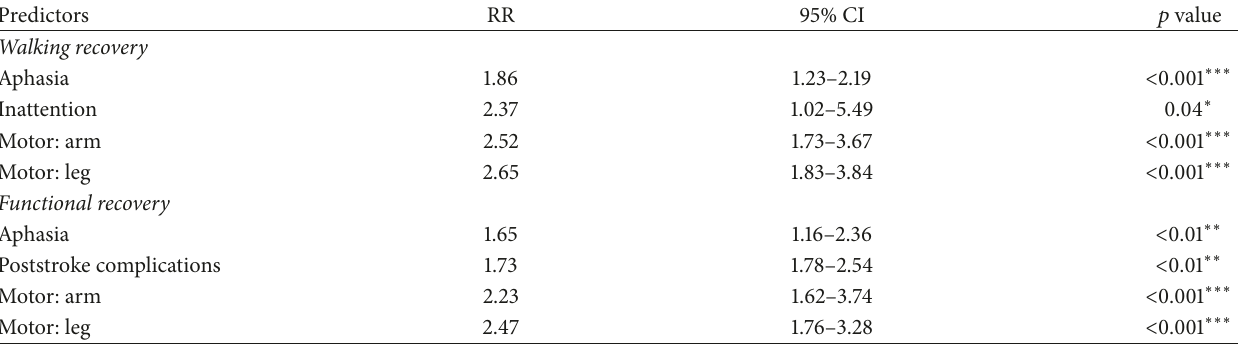
Table 3: Independent predictors of walking and functional recovery from left-sided hemispheric stroke from a univariable analysis with the generalized linear